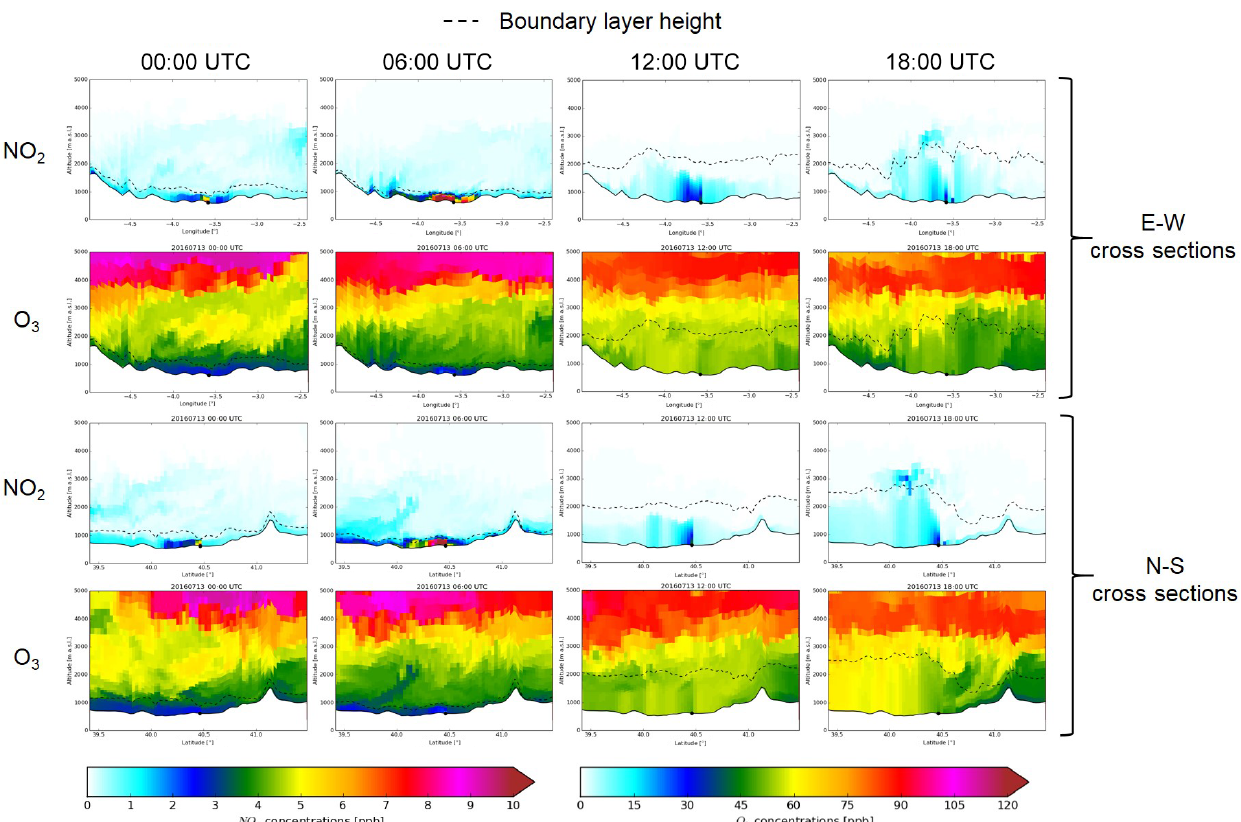
Figure 8. Simulated longitudinal and latitudinal vertical cross sections of NO 2 and O 3 for 13 July 2016 (WRF_70 run). See Fig. 1 to consult the latitudinal and longitudinal